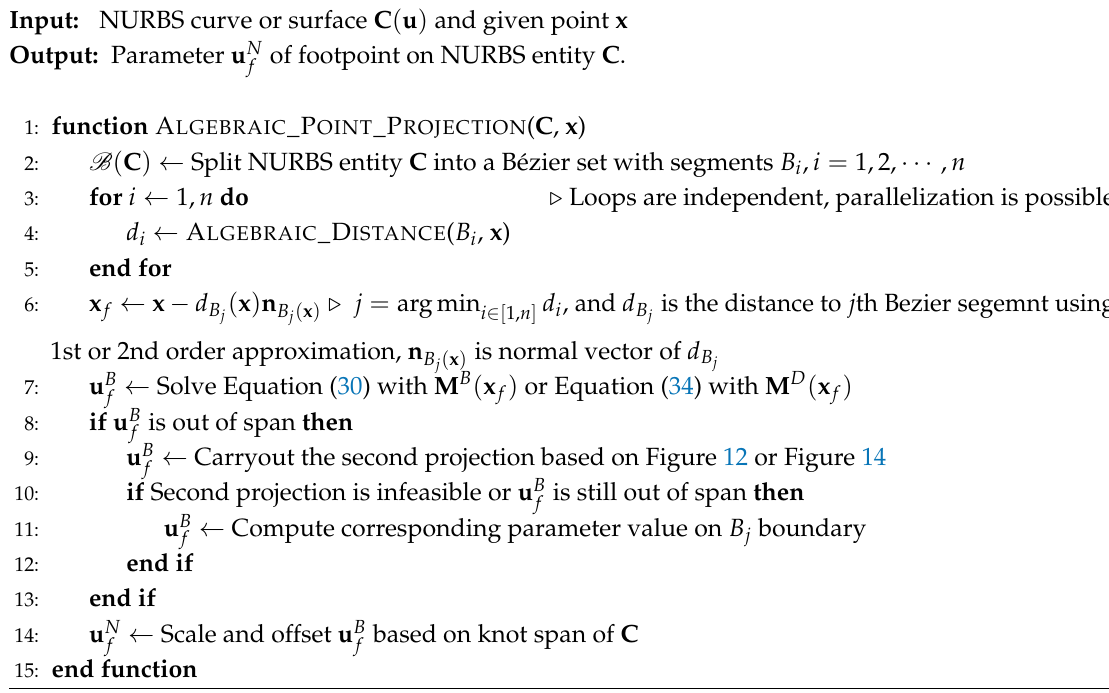
Table 3. Time complexity of each step in Algorithm 2 for algebraic point projection. Time complexities are listed for NURBS curves of degree p and NURBS surfaces of degree p × q . Time Complexity Step